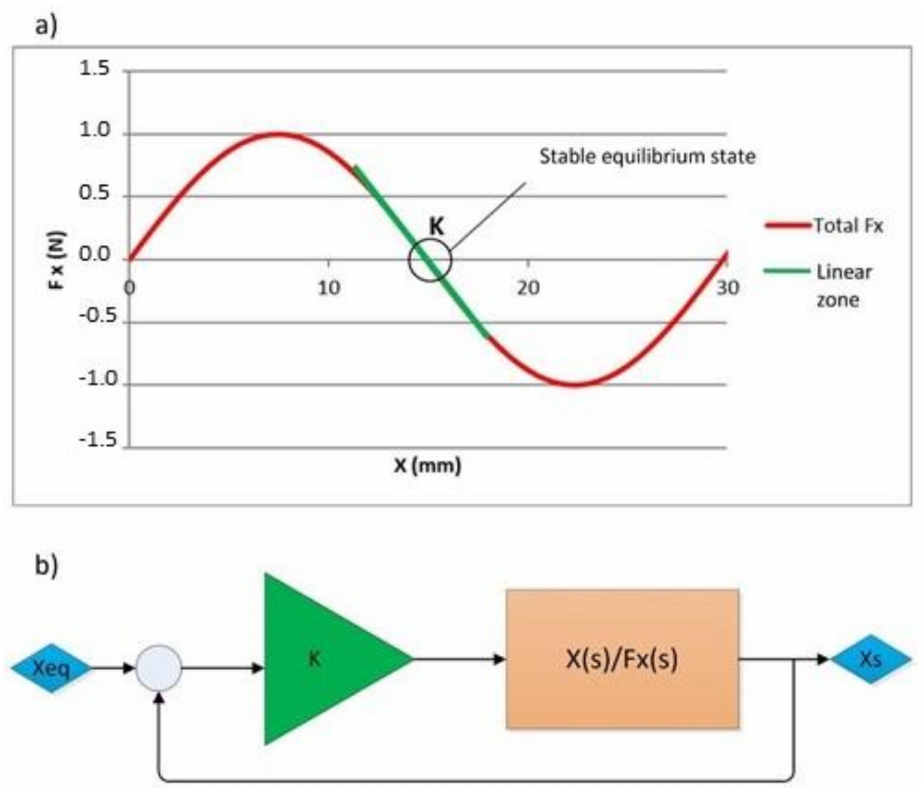
Figure 3. Linear zone around equilibrium position ( a ) and representation of the system in the linear zone ( b